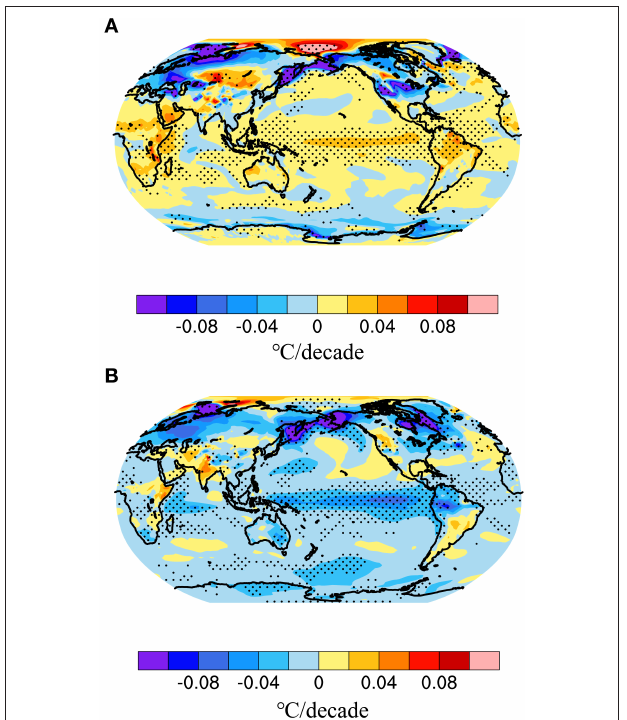
FIGURE 4 | The linear trend ( ◦ C/decade) of the surface temperature standard deviation during 1960–2100 in (A) the Strong_ICV and (B) Weak_ICV group, respectively. Note that the dotted indicates the region where the trend is statistically significant at the 95% confidence level compared to the ensemble mean trend.